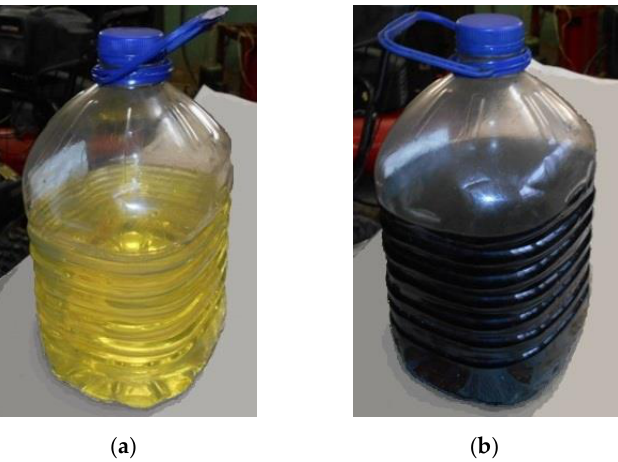
Figure 5. Initial petroleum diesel fuel ( a ) and mixture of petroleum diesel fuel with 250 mg/L